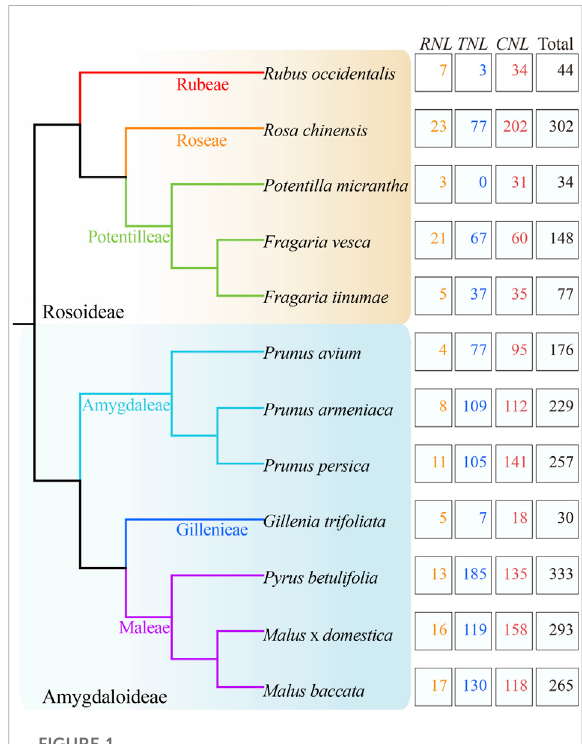
FIGURE 1 Identi fi cation and classi fi cation of NBS-LRR genes in 12 Rosaceae genomes. The phylogenetic tree (left) was constructed according to Xiang et al. (2017). The total number of NBS-LRR genes and their classi fi cation in each species (right) are